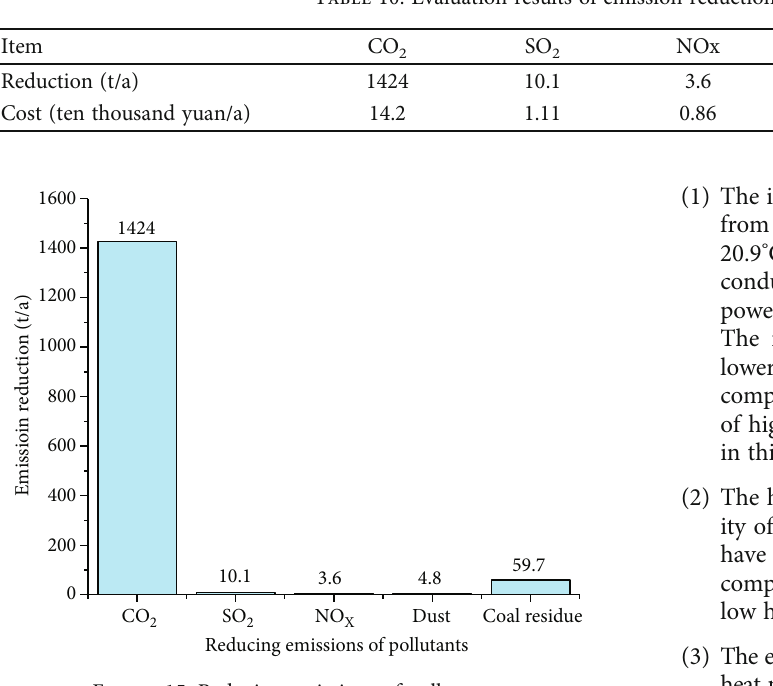
Figure 15: Reducing emissions of